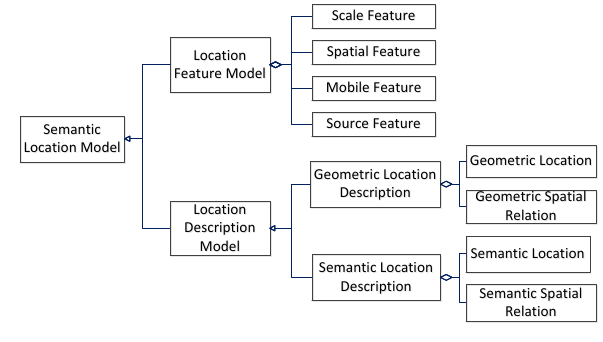
Figure 3. Semantic Location